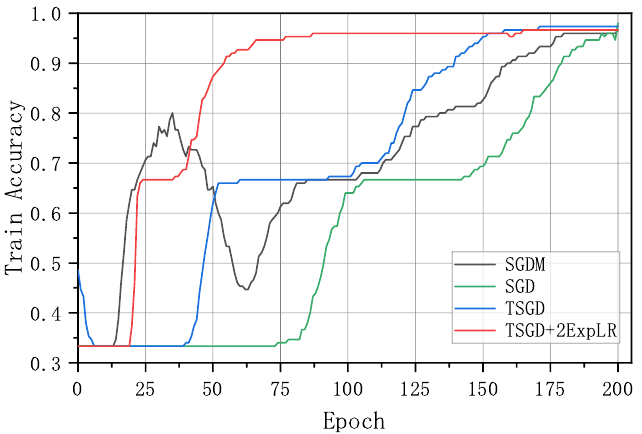
Figure 4. The accuracy of IRIS-BP-neural-network on the training set.